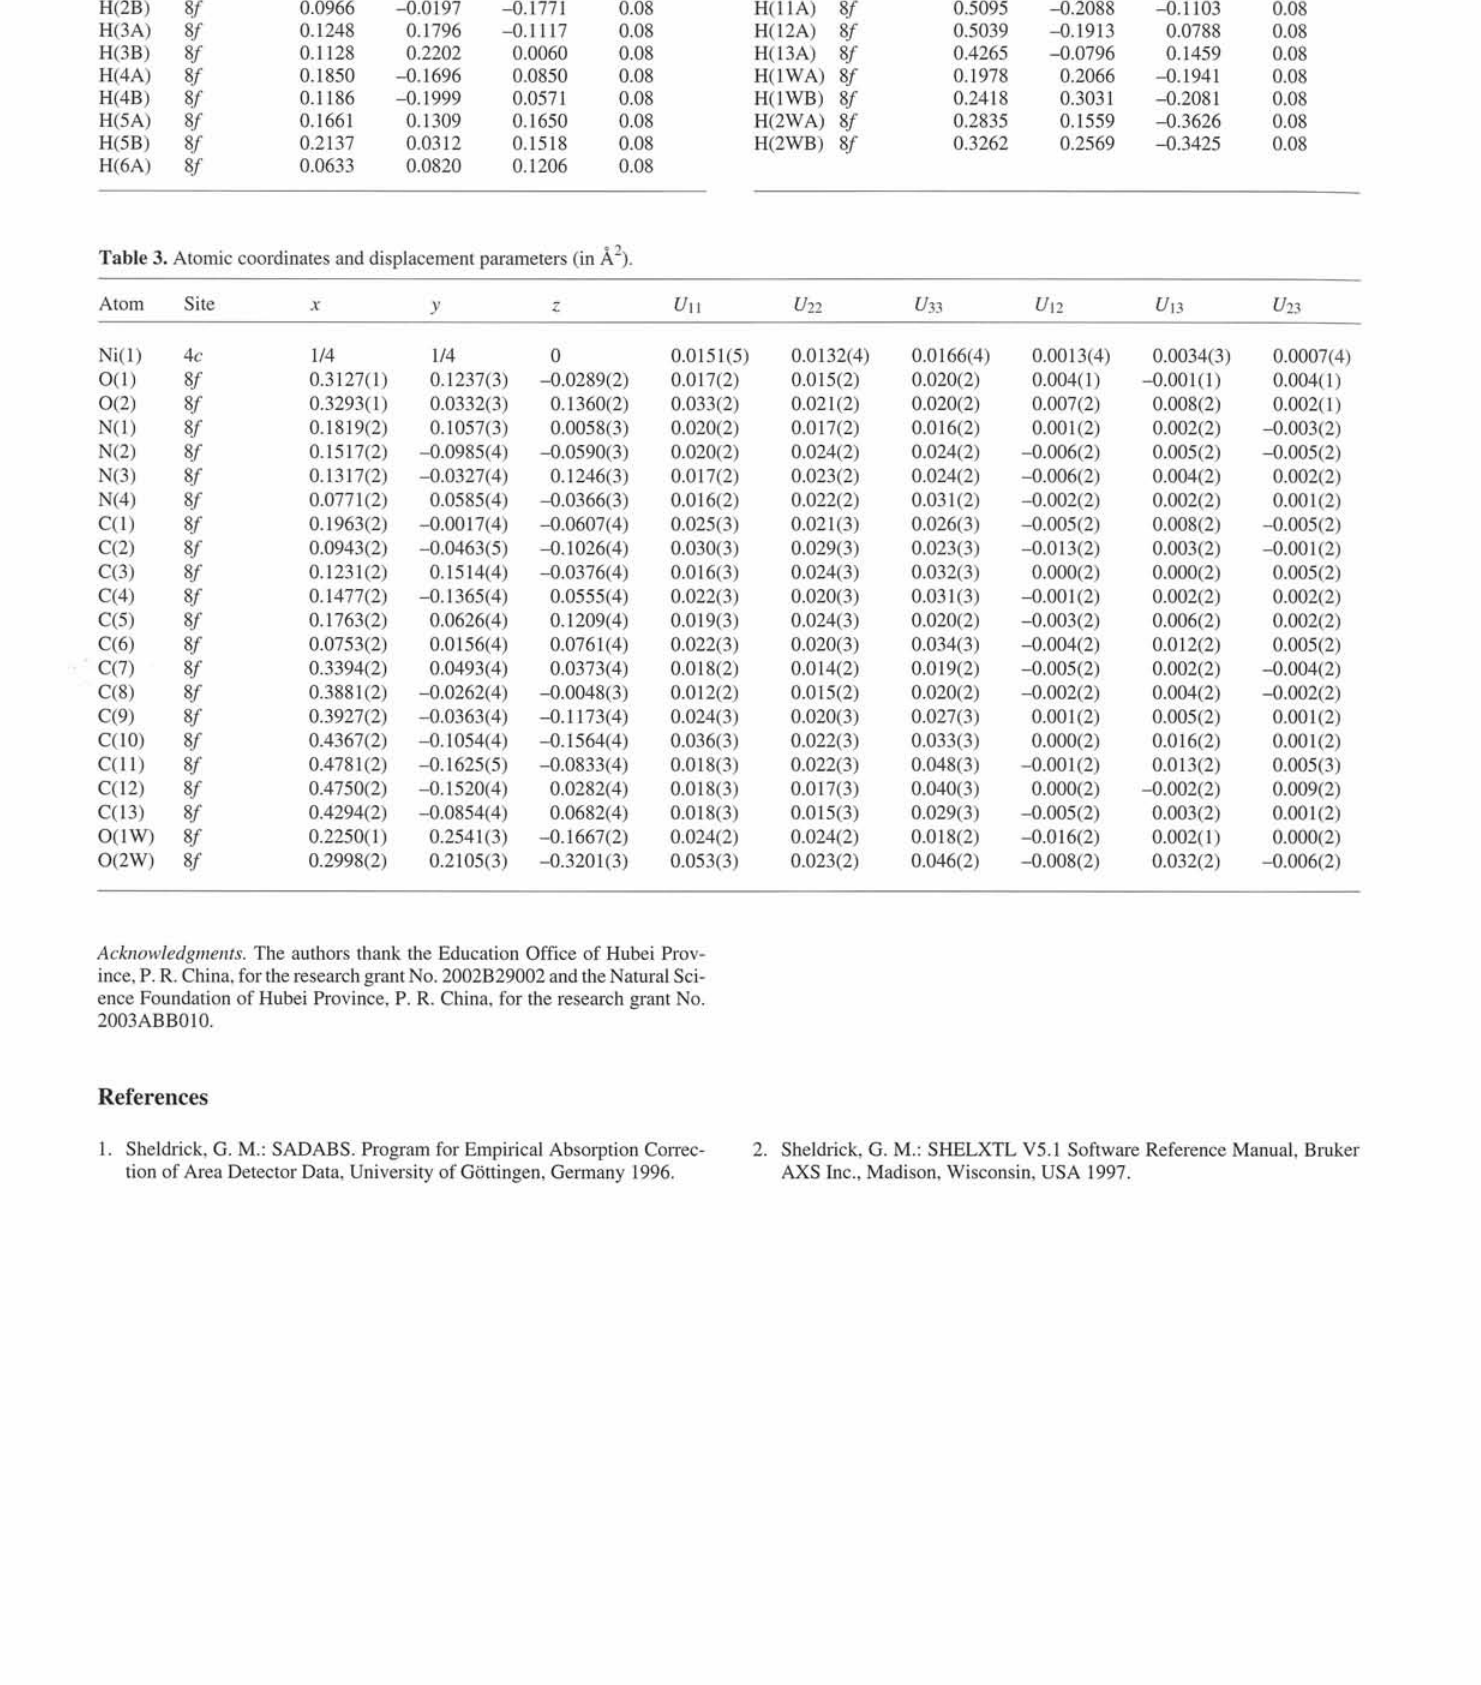
Table 3. Atomic coordinates and displacement parameters (in